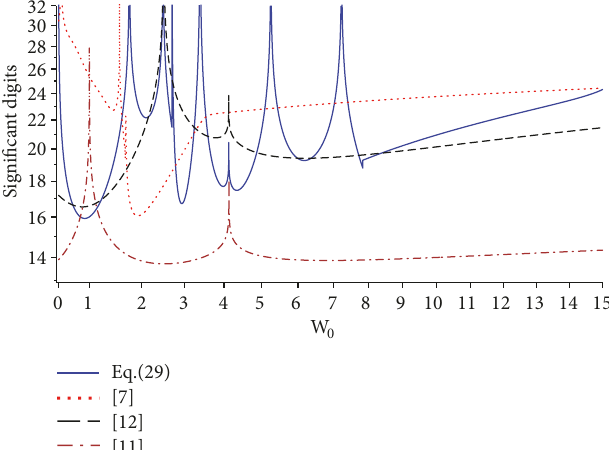
Figure 4: Significant digits for (29) and other ones reported at [7, 11, 12] after a single pass of iterative scheme of (30) for the interval of 𝑥 = [0,1 E 12] .